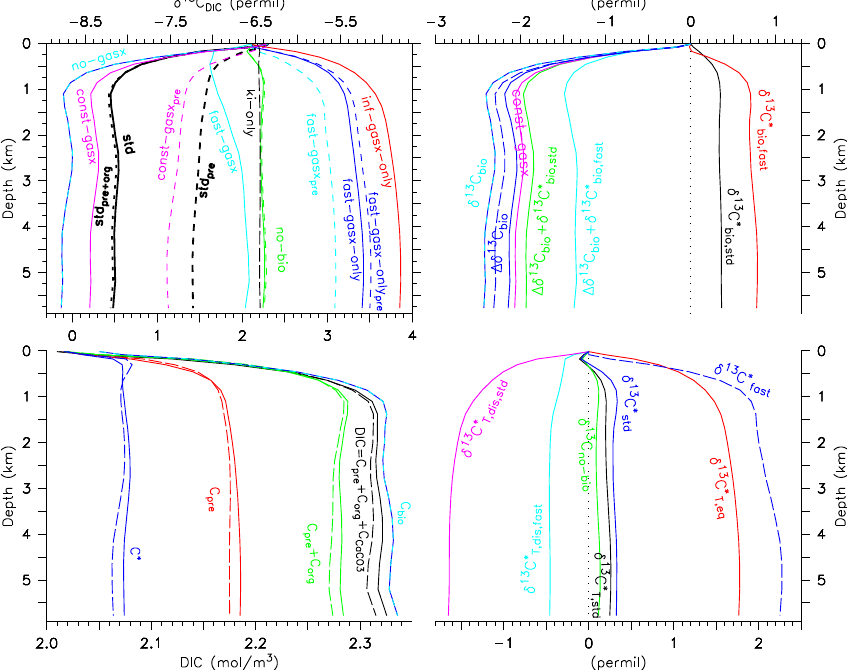
Fig. 5. Horizontally averaged vertical distribution of variables from preindustrial simulations. Top left: δ 13 C DIC (solid) and δ 13 C pre (dashed) for model std and some of the sensitivity experiments listed in Table 1. Experiments const-gasx and ki-only use the top axis, all other experiments the bottom axis. The curve for experiment bio-equil is identical to fast-gasx . The contributions from preformed plus organic (δ 13 C pre12 C pre + δ 13 C org12 C org )/( 12 C pre + 12 C org ) for std is shown as the dotted thick black line. The difference between that line and δ 13 C DIC , std (solid) represents the effect of CaCO 3 dissolution. Labeling is the same as in the top left panel of Fig. 4. Bottom left: DIC (black), 12 C pre (red), 12 C pre + 12 C org (green), C ∗ (blue) from models std (solid) and fast-gasx (dashed), and C bio from model no-gasx (light and dark blue dashed). Right panels: effects of biological fractionation and air–sea gas exchange on horizontally averaged δ 13 C DIC expressed as anomalies from surface values. Labeling is the same as in the right-hand panels of Fig. 4.